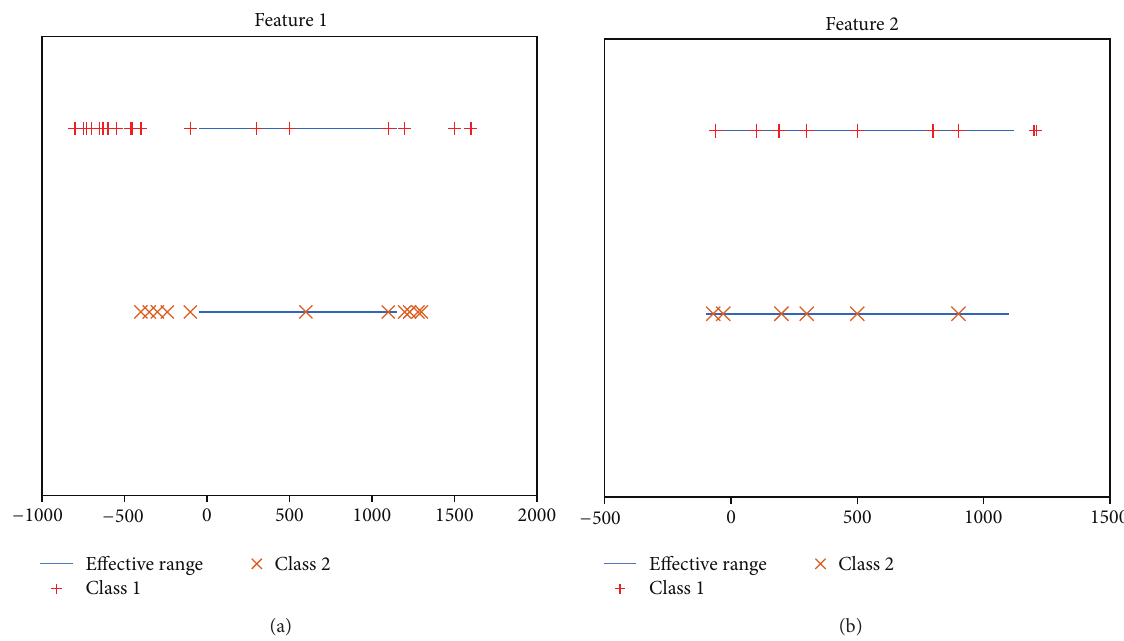
Figure 2: Different feature with the same size of overlapping area but different sample proportions in the two